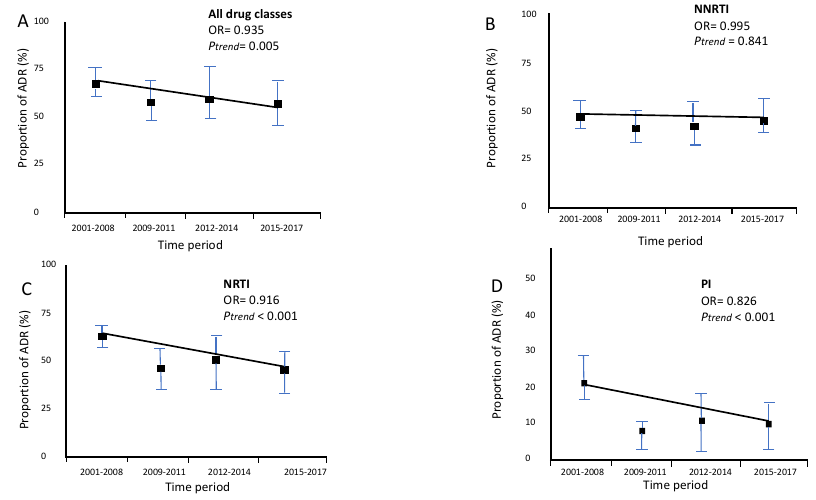
Figure 5. Trends of proportion of ADR in migrants followed up in Portuguese hospitals (2001–2017). ADR. ( B ) Trend for Acquired NRTI resistance. ( C ) Trend for Acquired NNRTI resistance. ( D ) Trend for Acquired PI